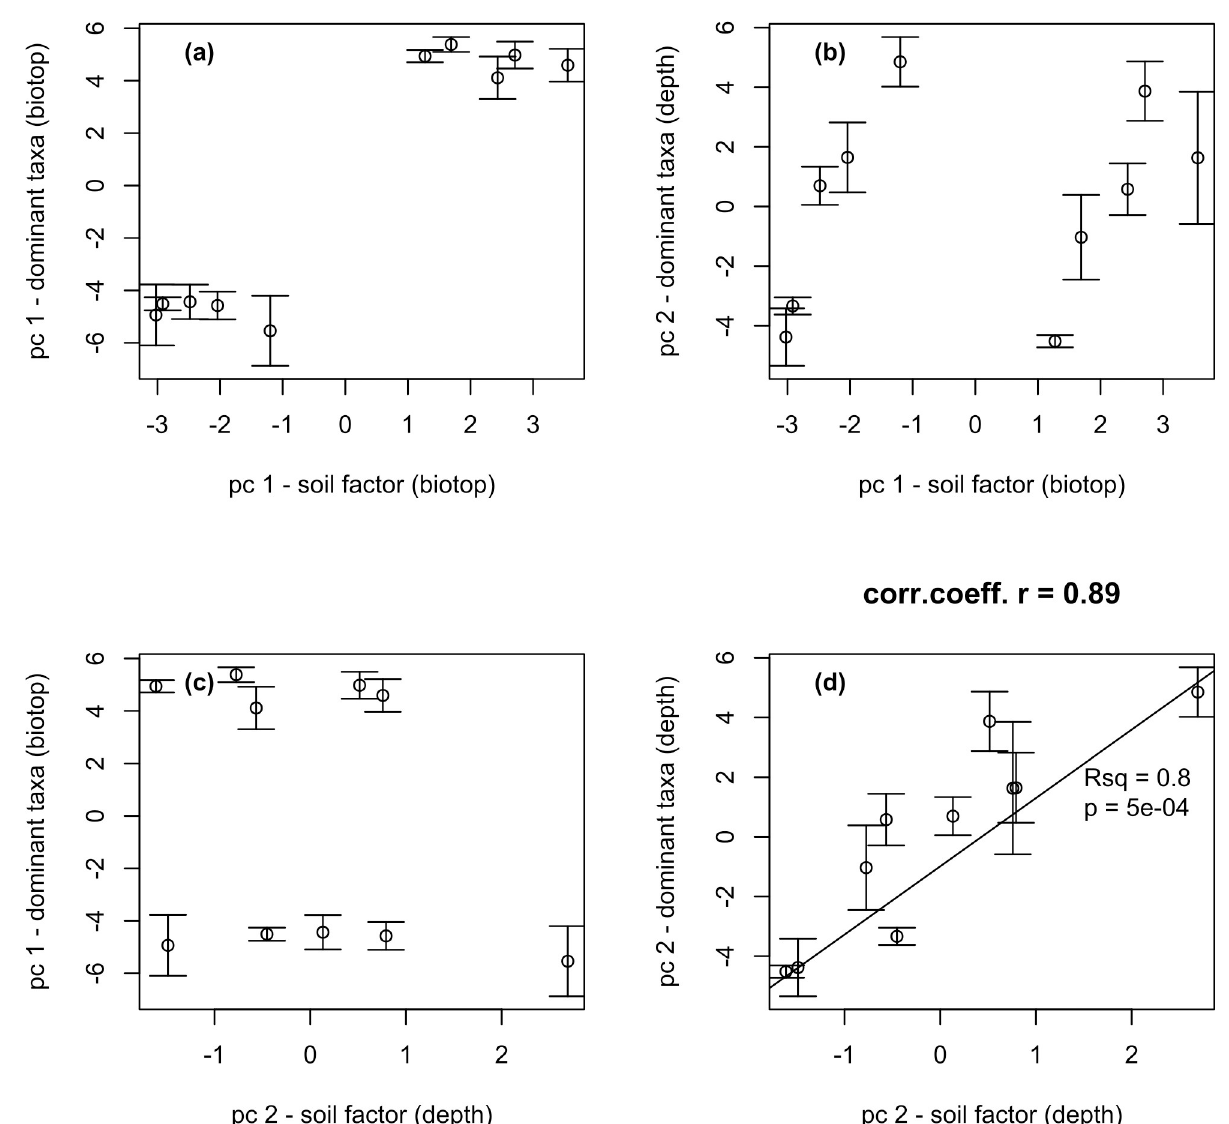
Fig 6. Correlation analysis between the two major components of taxa and the two major components of chemical